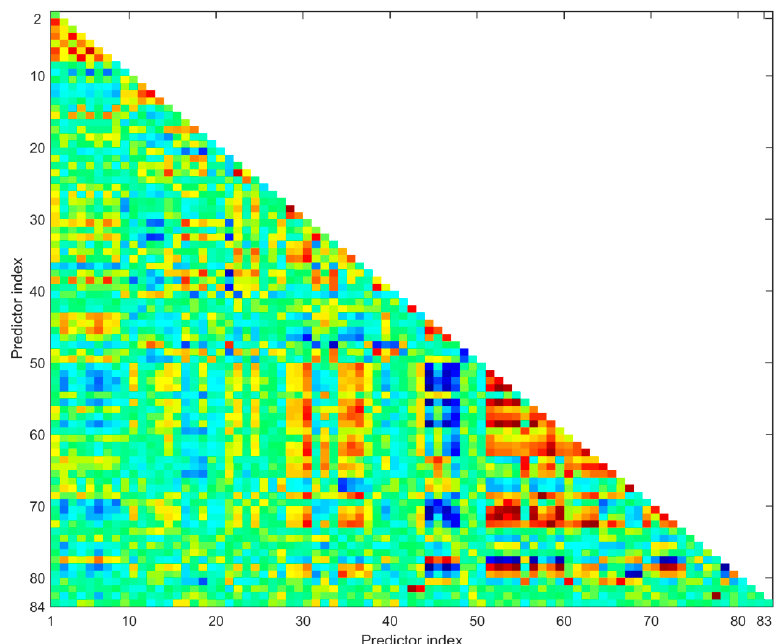
Figure 2. Pearson correlation maps for 84 predictors selected in the study during 1952–2012. The names of predictors corresponding to the indices are listed in the Appendix A.